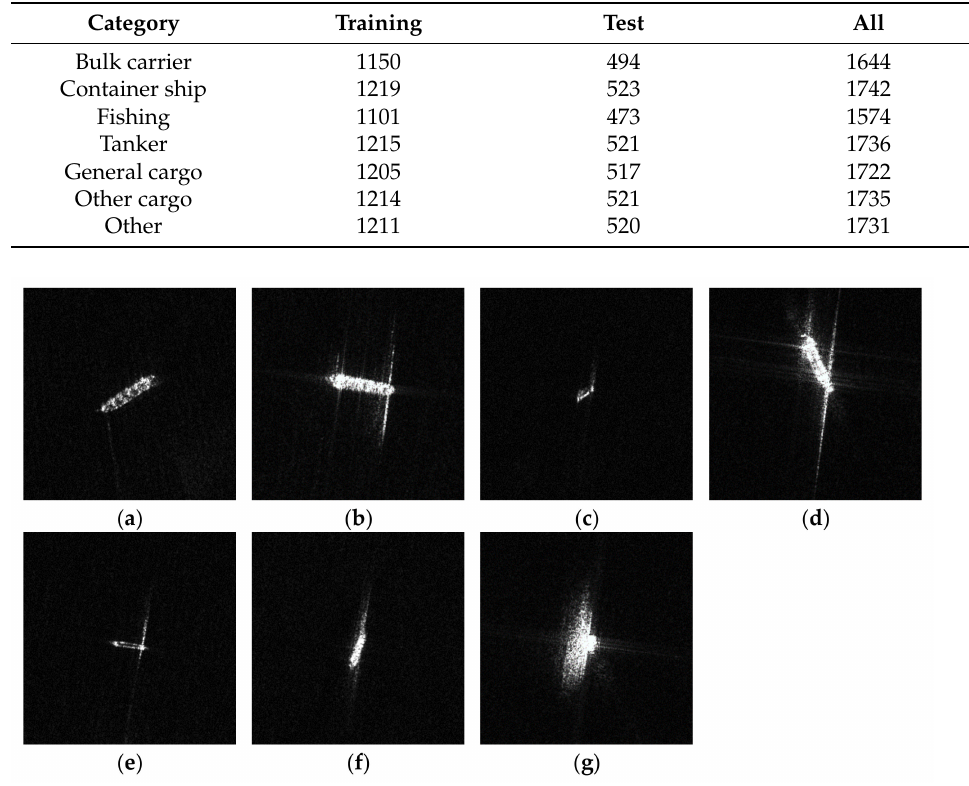
Table 3. Training and test set of the FUSAR-Ship dataset.